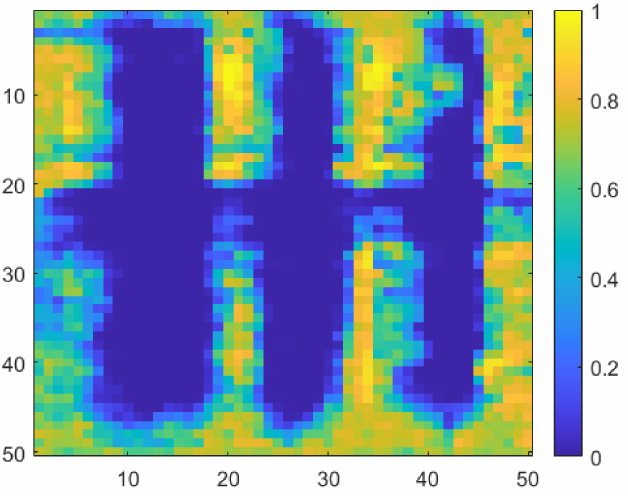
Figure 11. Sample target for sub-THz imaging: ( a ) photograph of a sample with different copper widths; ( b ) digitalized image of the sample to image correlation.